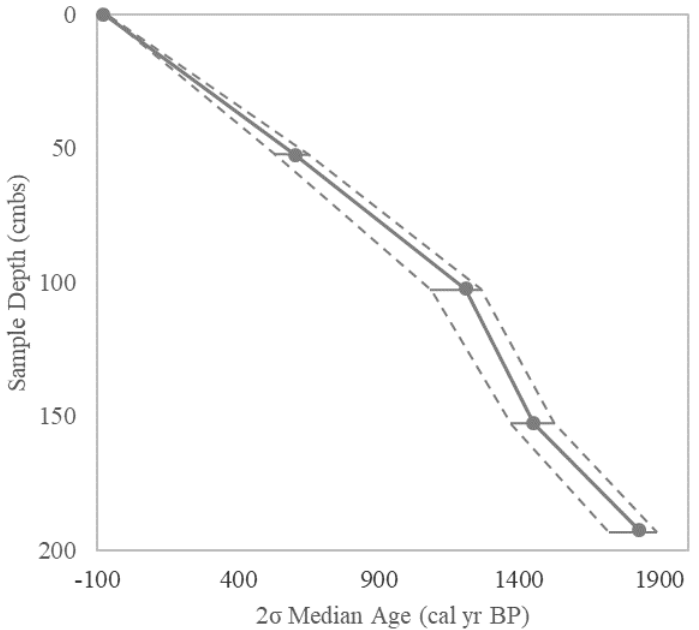
Figure 4. The radiocarbon age/depth curve is plotted for the Vilano Boat Launch core, where multiple radiocarbon dates were obtained. The data points represent the mid-point of the sample interval sent for radiocarbon age determination and the calibrated, 2 σ median age in cal BP. The solid line connecting the points represents the linear interpolation between dated horizons. The dashed lines indicate the calibrated 2 σ age ranges for the radiocarbon ages. The surface sample is assigned an age of − 78 cal yr BP given that the samples were collected in 2018 and present equals 1950 by convention. Table 4. Carbon sequestration data for the Vilano Boat Launch core are presented for depth intervals based on interpreted wetland environment (mangrove vs. salt marsh) and by differences in sedimen- tation rate between bracketed radiocarbon ages. The presented carbon percentages, sedimentation rates, and bulk densities represent averages for those sample depth